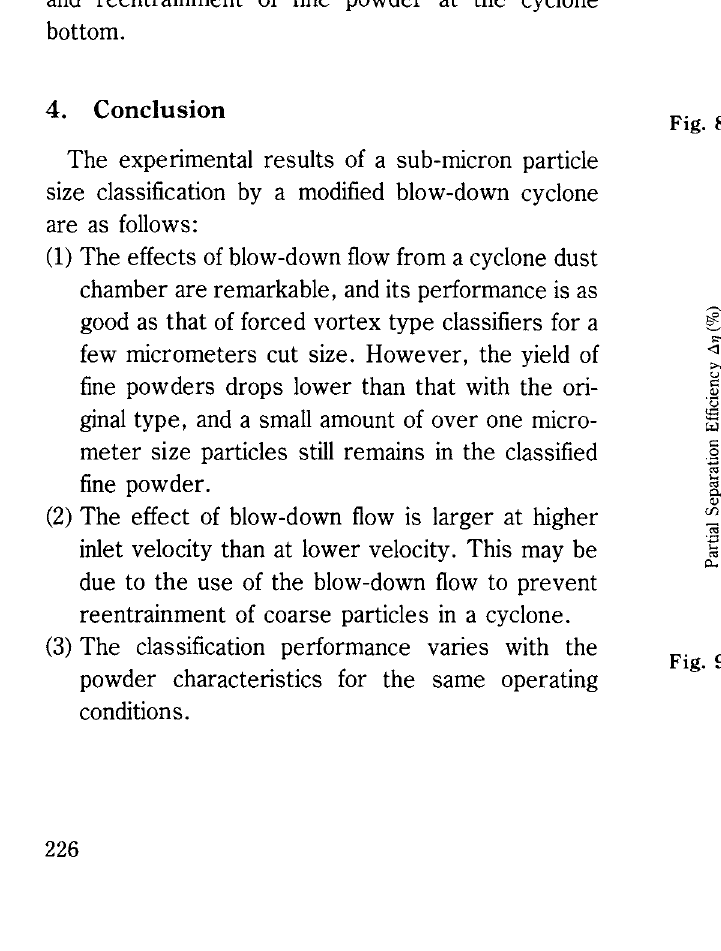
Fig. 8 Partial Separation Efficiency of 2 Stage ¢70 Cycle Classi fier (Type II) Measured by Different Methods